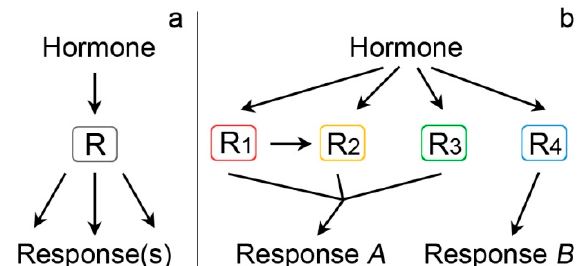
Figure 4. Model of conventional hormonal input via a single receptor (R) leading to downstream responses ( a ); model of SA multinodal input via multiple SABPs acting as independent receptors ( b ). Some receptors in model B may be in a functional connection (e.g., a putative SA-binding TRX acting on NPR1) and act in a single reception pathway.